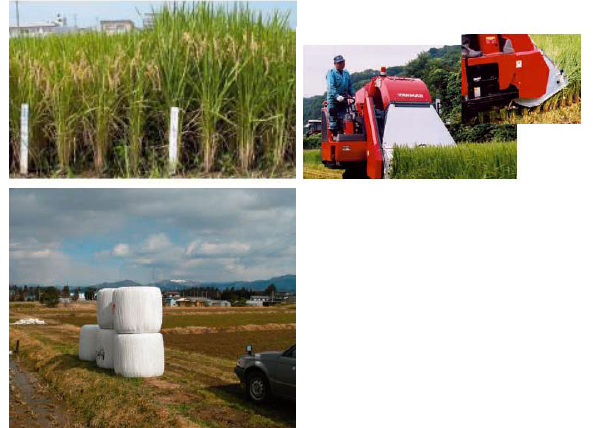
Figure 2. Whole-crop-silage-paddy rice, its harvest and its roll- bale-silage (Ministry of Agriculture, Forestry and Fisheries, 2016a)